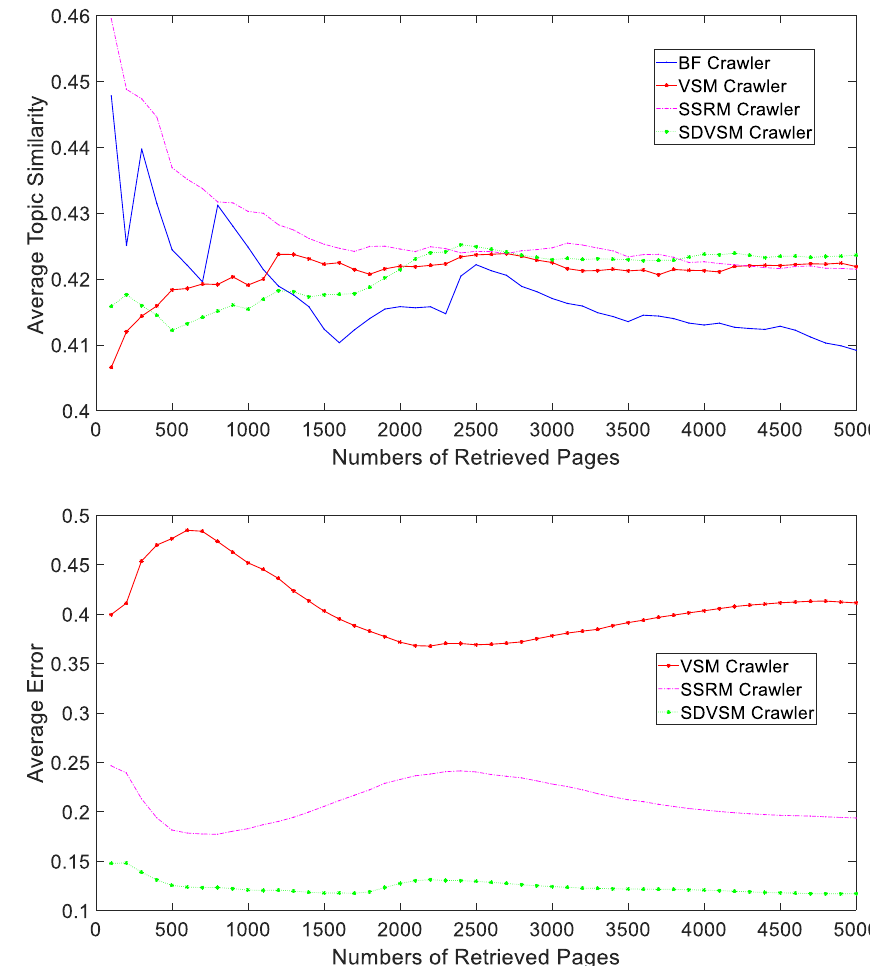
Fig. 8 The comparison of the average topic similarity for four focused crawlers based on the first group results